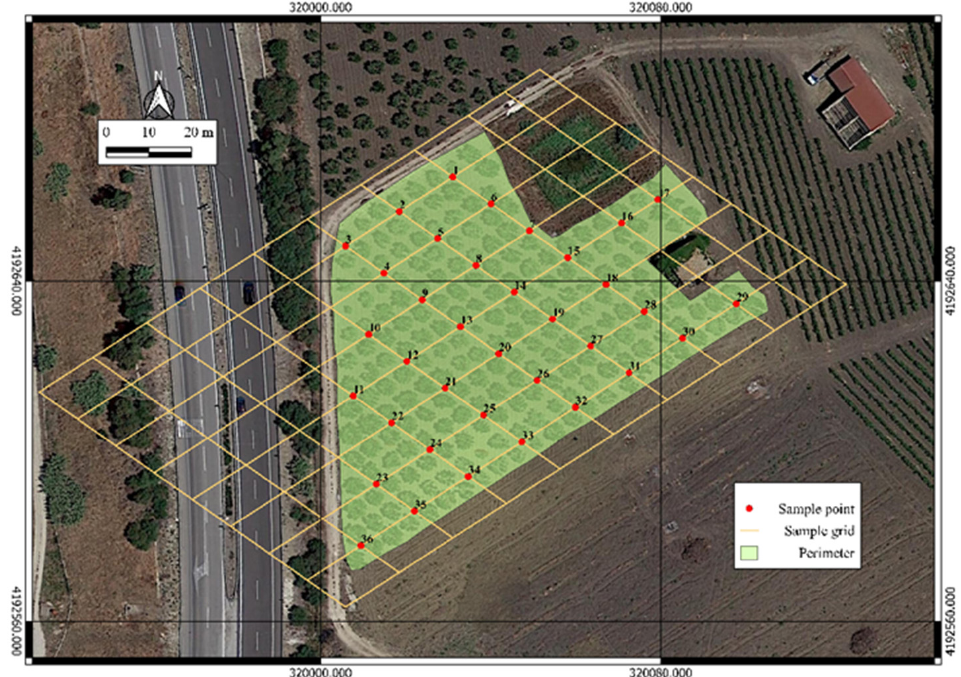
Figure 4. Sample grid and sample points used for nutritional and soil condition characterization.